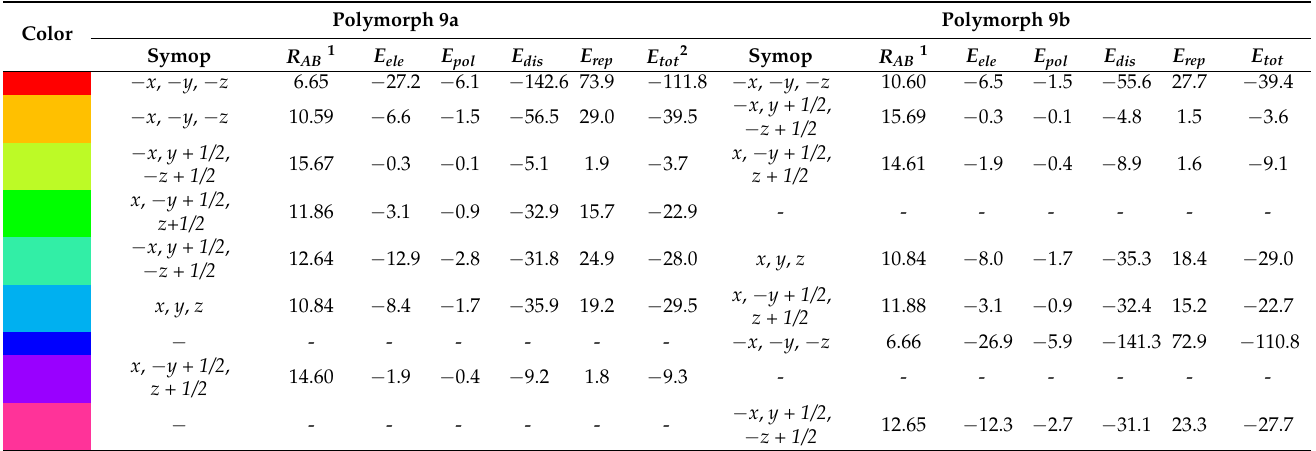
Table 4. Interaction energies (in kJ/mol) for pairs of molecules (AB) in crystals 9a and 9b calculated with the CE-B3LYP model. Each color represents a particular interaction between the central molecule and a different symmetry-related molecule.